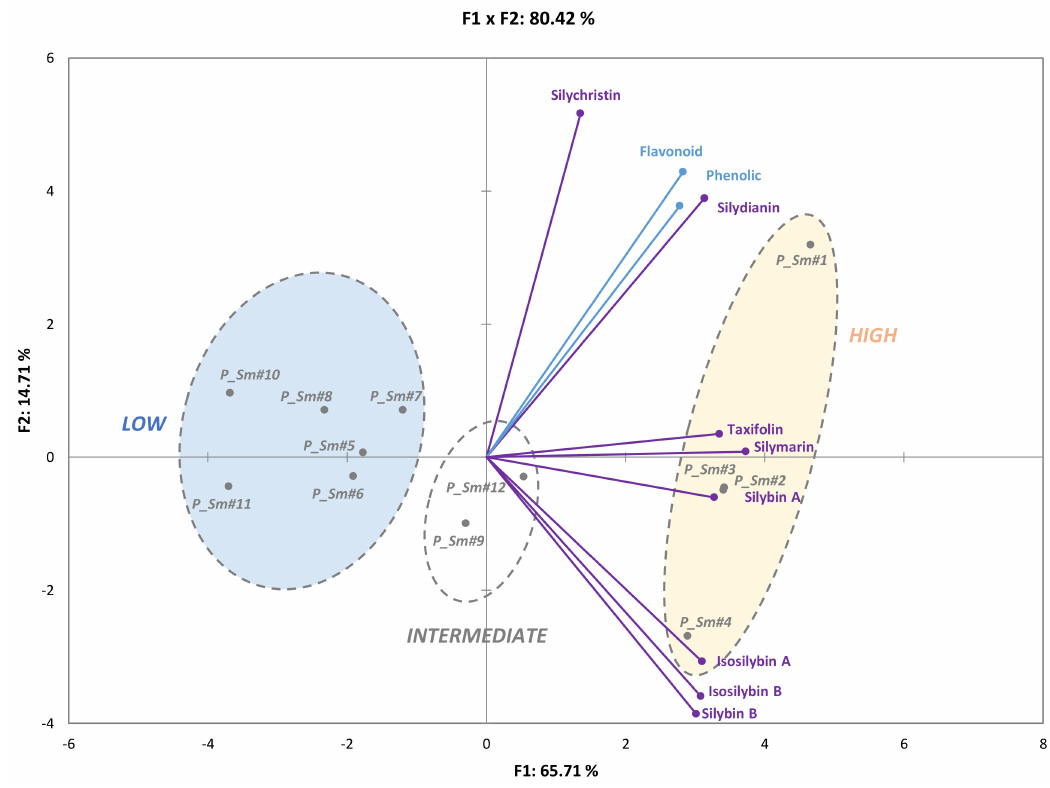
Figure 5. Principal component analysis (PCA) of the different silymarin compounds and its extraction from twelve inflorescences. Variance of factor 1 (F1) = 65.71% and of factor 2 (F2) = 14.71%. Ecotypes are distributed into the three groups (Low, intermediate and high) according to their amount of